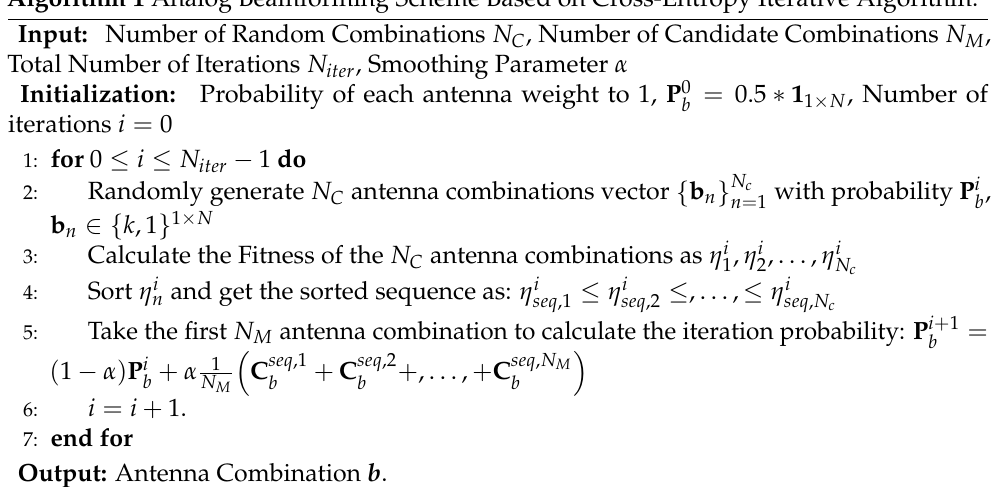
Algorithm 1 Analog Beamforming Scheme Based on Cross-Entropy Iterative Algorithm.